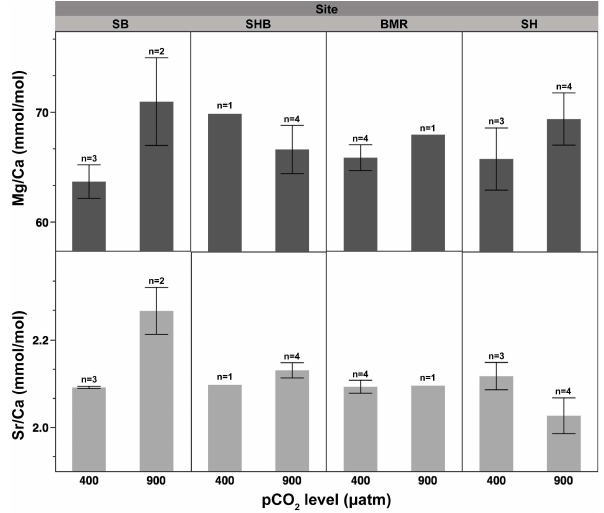
Fig. 5. Mean Mg/Ca (upper) and Sr/Ca (lower) ratios of newly metamorphosed juvenile S. purpuratus urchins, settled after 48– 49days in culture at control (400µatm) or elevated p CO 2 levels (900µatm). Cultures initiated from sites indicated in Fig. 1. Error bars represent ± 1SE of 2–4 samples (consisting of ∼ 20 pooled metamorphs) from replicate culture jars from each population.